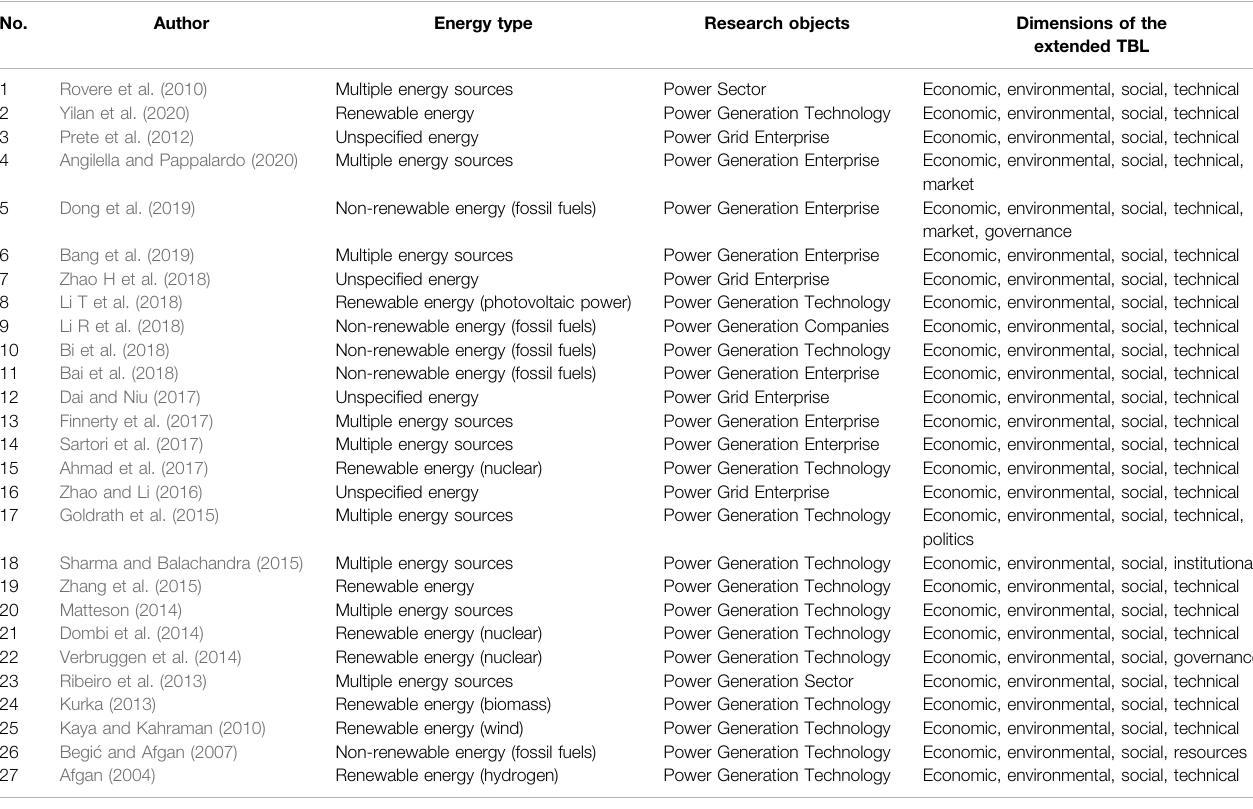
TABLE 4 | Summary of these articles using the extended triple bottom line.